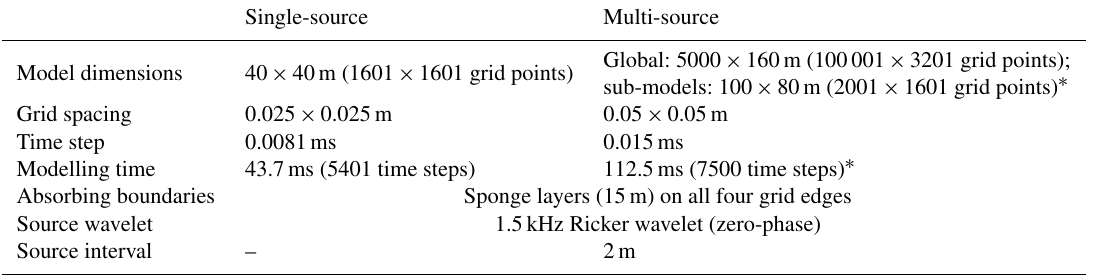
Table 2. Modelling parameters for the single-source and multi-source synthetic experiments. Rows marked with an asterisk are representative values, as the dimensions of the sub-model depend on the location within the global